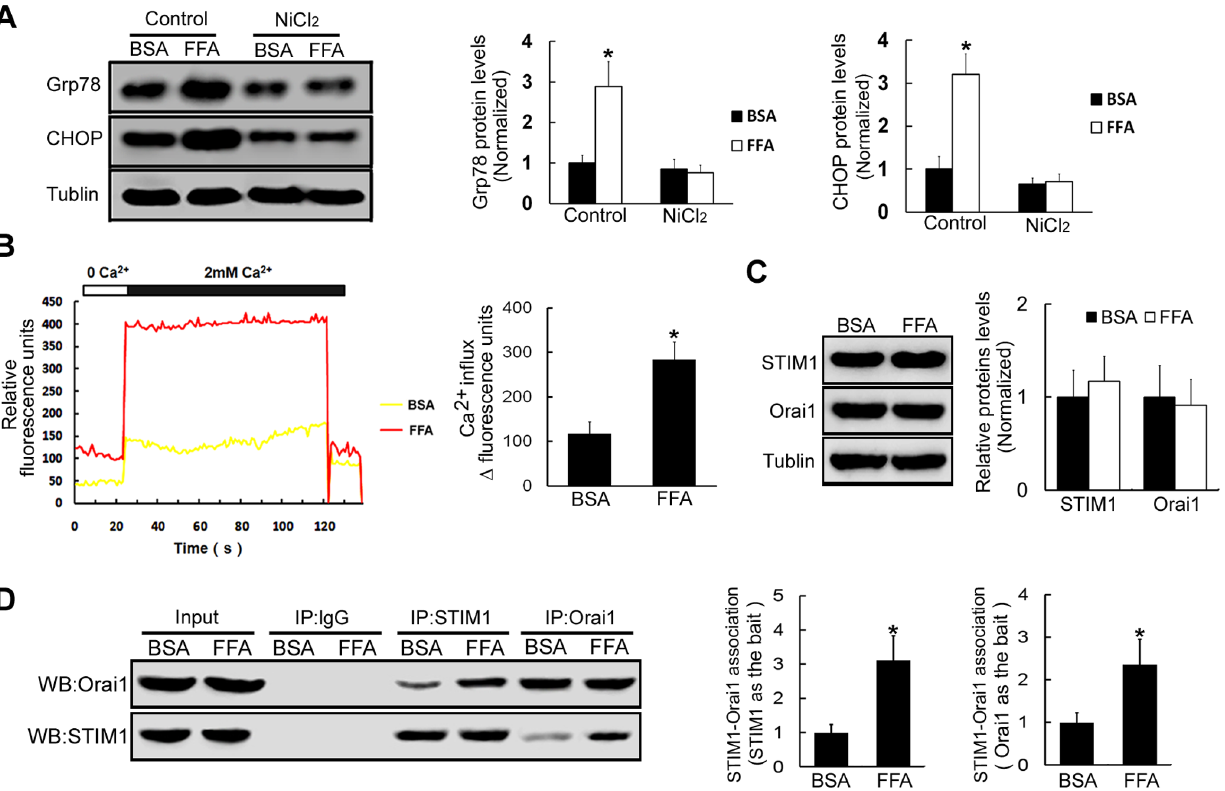
Figure 2. FFA treatments increase Ca 2 + influx to induce ERS in b -TC3 cells. (A) b -TC3 cells were incubated with FFA or BSA for 16 h, western blot was used to examine the protein expression levels of Grp78 and CHOP following the treatment with Ca 2 + channel blocker NiCl 2 . (B) b -TC3 cells were incubated with FFA or BSA for 16 h, and then stimulated with 4 m M thapsigargin for 20 min to activate store-operated Ca 2 + entry. Fluorescence densities of Ca 2 + change were monitored in Fluo-8/AM-loaded b -TC3 cells after FFA or BSA treatments. (C) The protein expression levels of STIM1 and Orai1 were tested by western blot following treatments with FFA or BSA for 16 h in b -TC3 cells. (D) b -TC3 cells were incubated with FFA or BSA for 16 h, and then stimulated with 4 m M thapsigargin for 20 min. Cell lysates were immunoprecipitated with anti-STIM1 antibody followed by western blot using anti-Orai1 antibody and with anti-Orai1 antibody followed by western blot using anti-STIM1 antibody. Immunoprecipitated with anti-IgG antibody was used as the negative control. Bars represent each sample performed in triplicate, and the error bars represent the standard deviations. * P , 0.05, by the Student’s t -test.